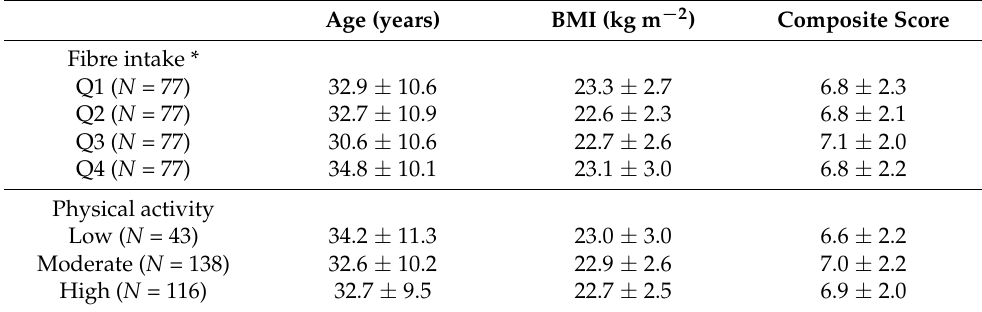
Table 2. Baseline characteristics of subgroups of subjects in Study 2 according to fibre intake and physical activity.